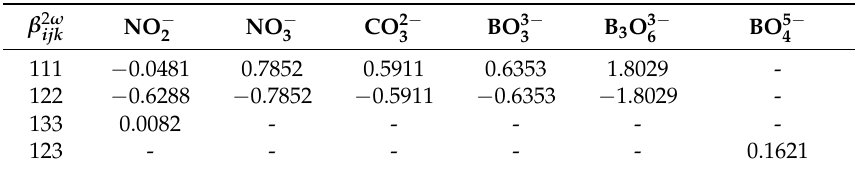
Table 1. The second-order NLO susceptibilities of some simple anionic groups * (in unit: 10 − 31 esu, conversion factor: 1 esu = 4 π /3 × 10 − 4 m/V).